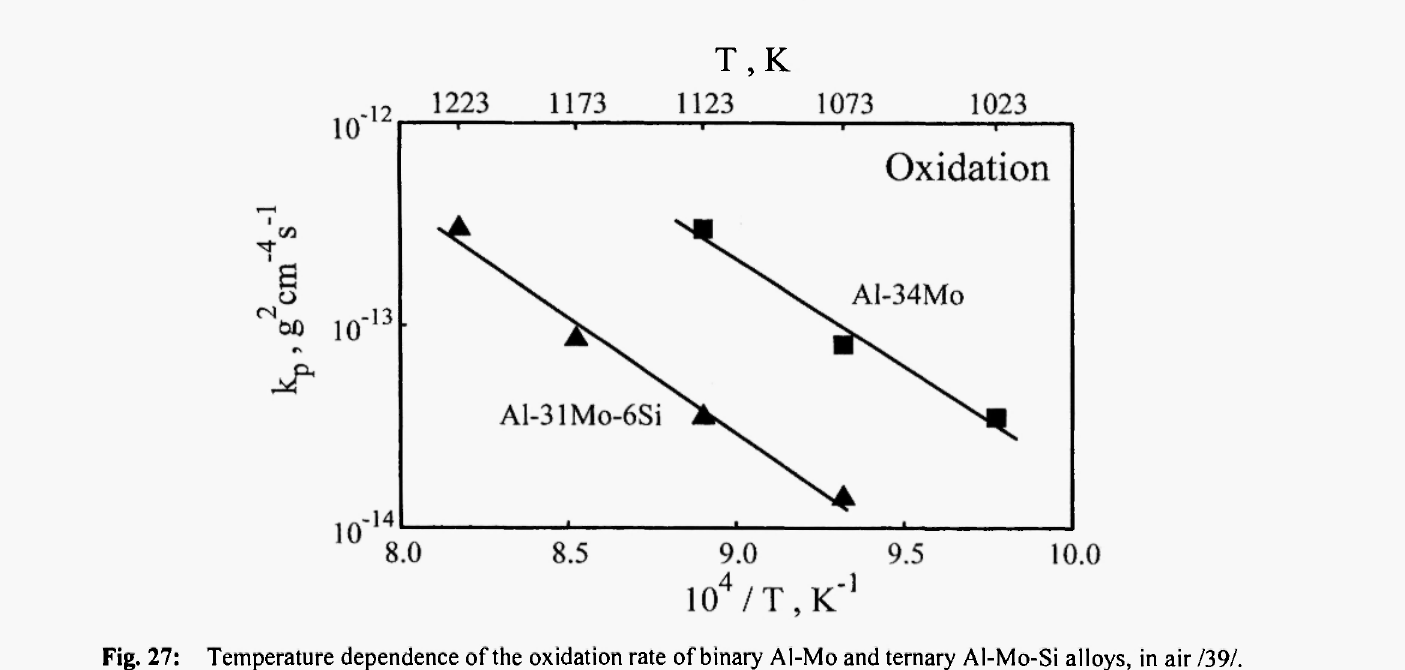
Fig. 27: Temperature dependence of the oxidation rate of binary Al-Mo and ternary Al-Mo-Si alloys, in air 1391.